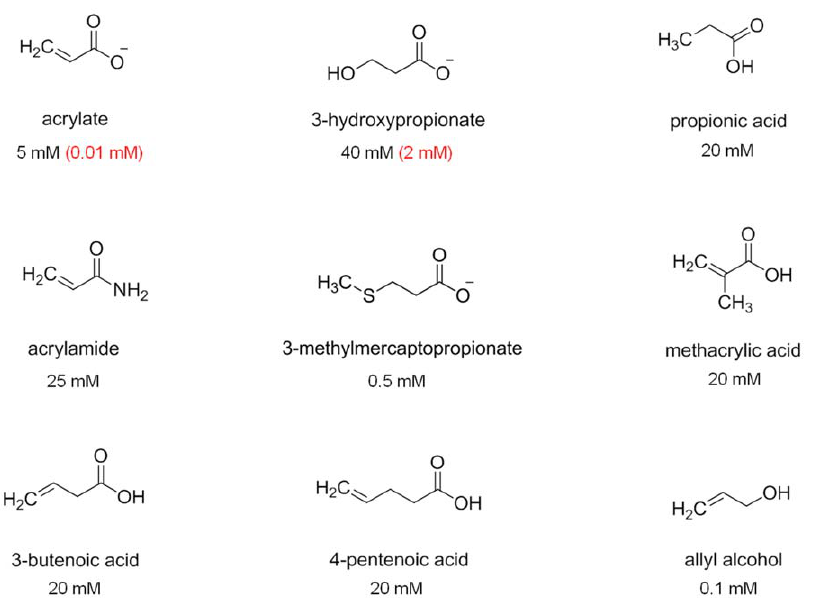
Figure 4. Chemical formulae of agents tested for their effects on the growth of Escherichiacoli. Values below each chemical indicate the highest concentrations tested at which the E. coli wild type strain would grow. Where there was a difference between the wild type and the YhdH 2 mutant strain, the maximum concentration at which the mutant would grow is shown in brackets.